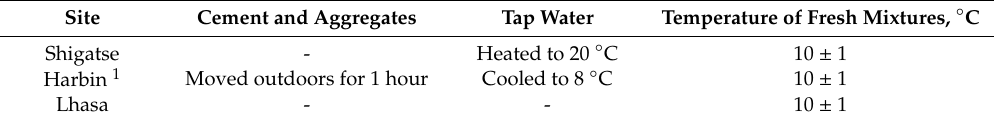
Table 4. Pretreatments of raw